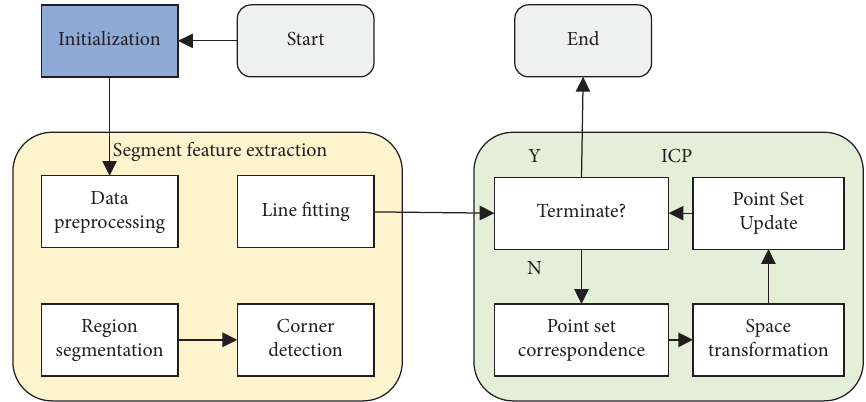
Figure 6: ICP algorithm fow based on line segment